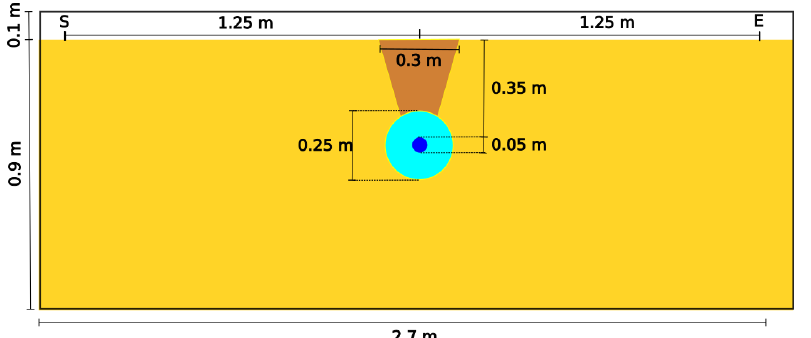
Figure 7. Model geometry used for a numerical simulation in the case of a model leaking pipe. The inside 0.025 m-radius pipe, filled with water (velocity of 0.033 m/ns), is at the bottom of a trench (brown) (0.09 m/ns), surrounded by a 0.15 m radius water-saturated cylinder (0.05 m/ns). The surrounding medium is in yellow (0.1